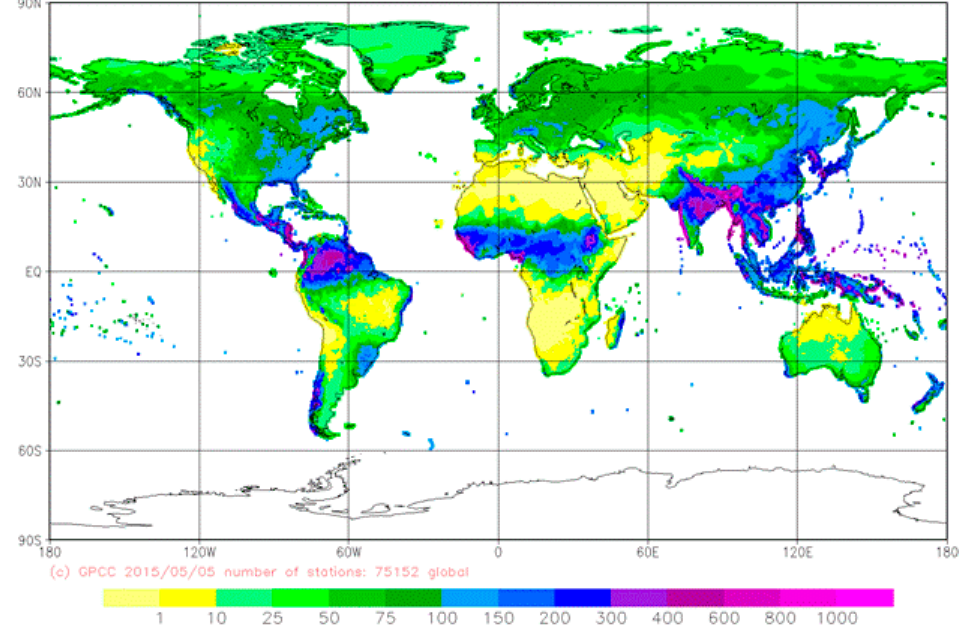
Figure 3. Climatological mean precipitation for July based on new Global Precipitation Climatology (Version 2015) from the GPCC, focusing on the period 1951–2000, 0.25° × 0.25° resolution).